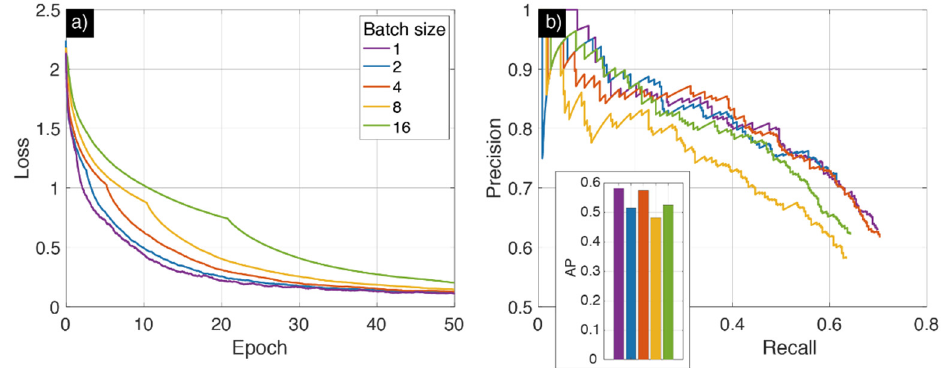
Figure 4. ( a ) Loss during training duration of 50 epochs for different batch sizes. ( b ) Recall–precision curves and AP for different batch sizes.